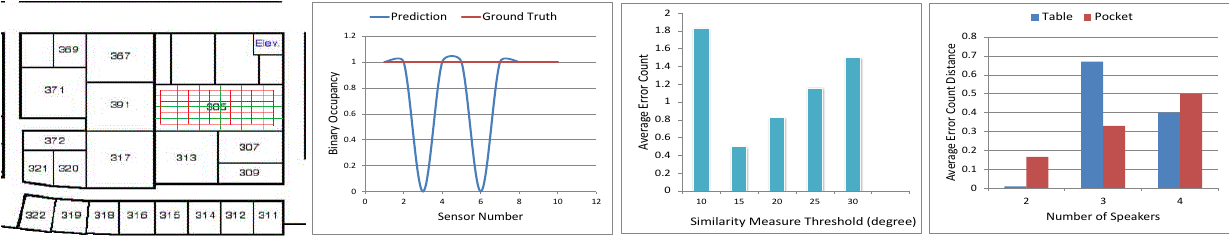
Figure 12: Performance with different cosine measures